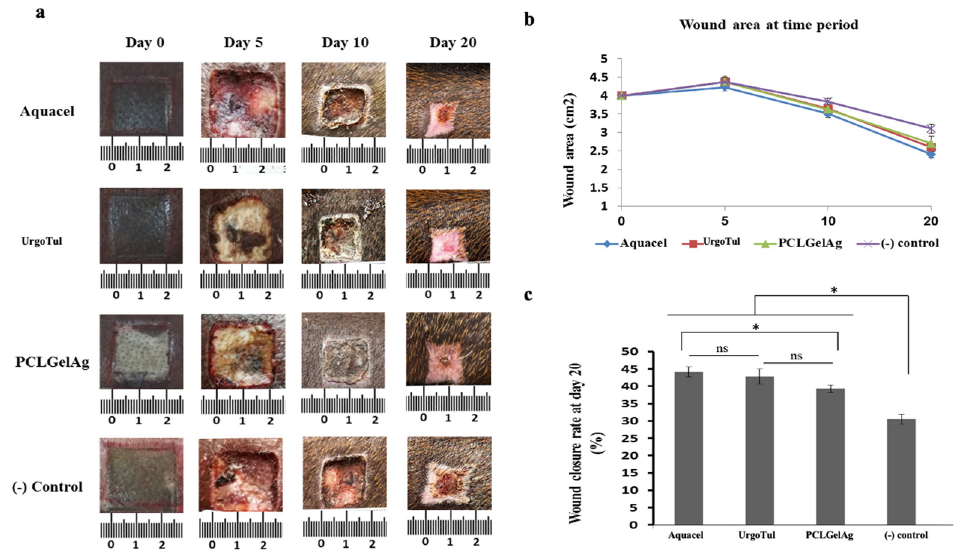
Figure 7. ( a ) Photographs of burn wounds treated with normal gauze (control), Aquacel, UrgoTul and PCLGelAg membranes at day 0, 5, 10, and 20; ( b ) The wound areas were measured in cm 2 from day 0 to day 20 and presented in the line chart; ( c ) The bar chart indicates the wound closure rate after 20 days of treatment. *: p value < 0.05. ns: not